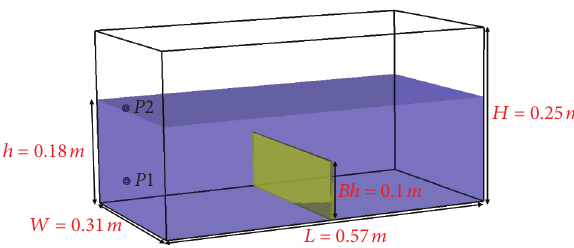
Figure 3: The sketch of the tank with a vertical